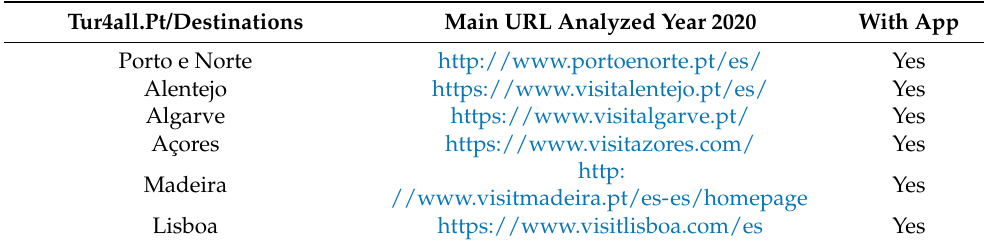
Table A2. Sample of official tourism websites of accessible destinations Portuguese shown in